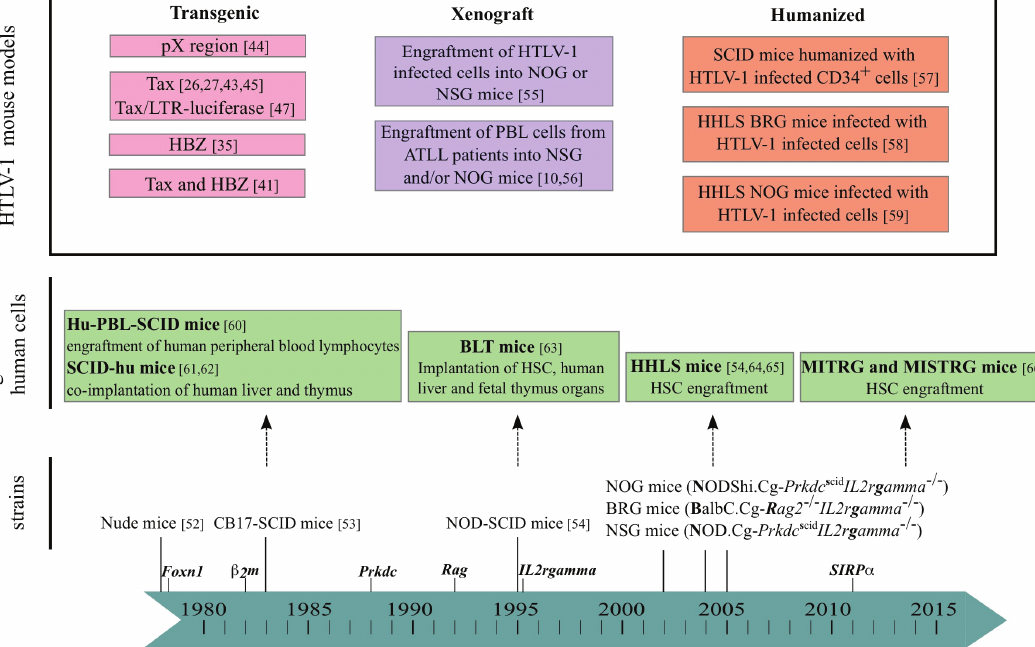
Figure 3. Mouse models in the study of HTLV-1 leukemogenesis. Transgenic immunocompetent mice were mainly used to investigate the role of HTLV-1 Tax and HBZ (see pink boxes). From the beginning of the 1980s, several strains of immunodeficient mice have been isolated and/or developed through the introduction of various gene mutations (in italics over the blue chronological scale). The tumorigenic potential of HTLV-1 infected T-cells or of ATLL cells has been studied by engrafting these cells in immunodeficient mice (xenograft, purple boxes). Likewise, the engraftment of immunodeficient mice with either human lymphocytes or stem cells or lymphoid tissues has led to the generation of humanized mice (green boxes), prone to investigate the role of HTLV-1 infection in leukemogenesis (orange boxes). Hu: humanized; HSC: hematopoietic stem cells; PBL: peripheral blood lymphocytes; HHLS: human hemato-lymphoid system; BLT: bone marrow-liver-thymus; MITRG and MISTRG: M-CSF, IL3, TPO, MG-CSF and/or SIRP α (signal regulatory protein α ).